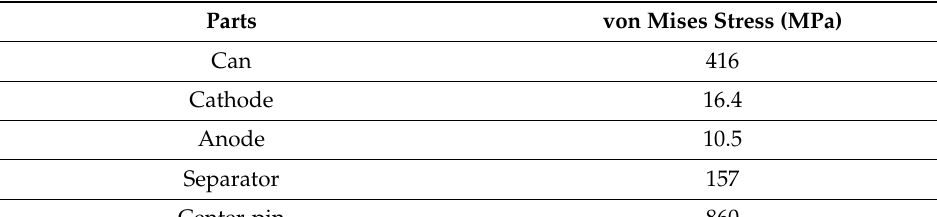
Table 2. The von Mises stress of each component at t = 2.7 ms.